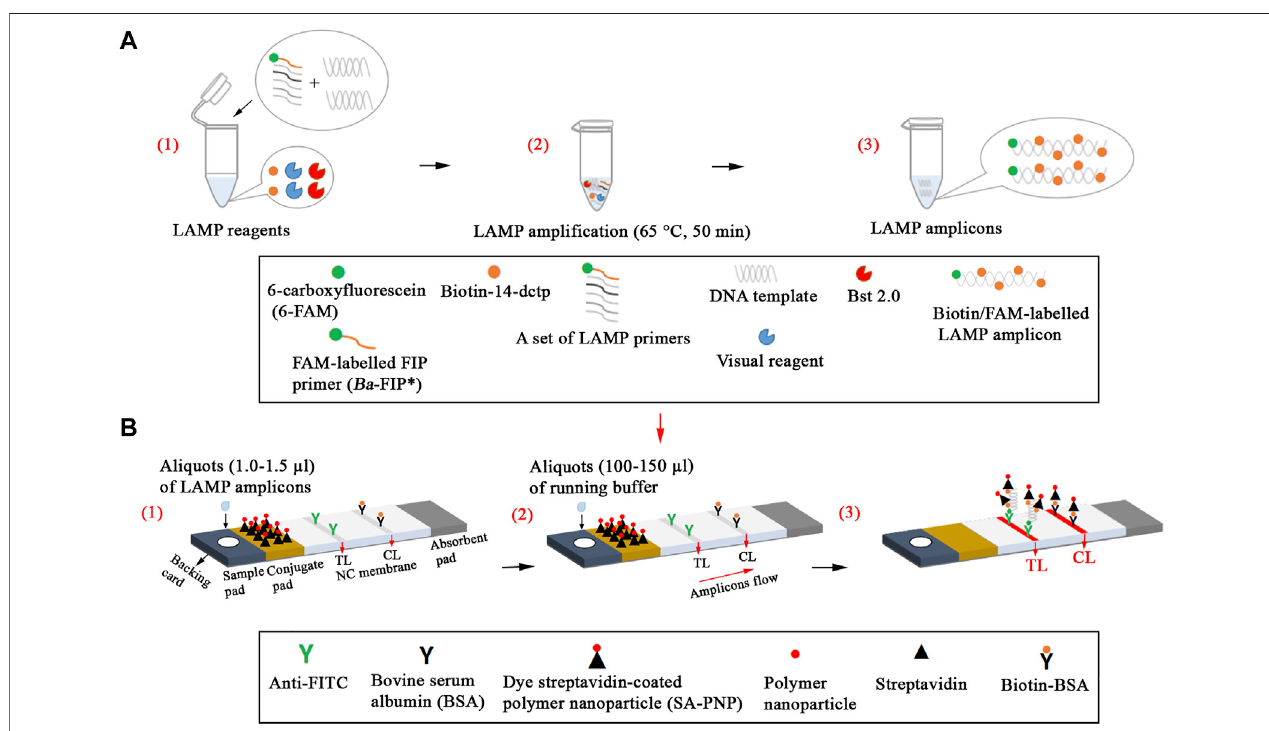
FIGURE 1 | Schematic description of the B. abortus -LAMP-LFIA assay. (A1) , Preparing the reaction mixtures. (A2) , B. abortus -LAMP ampli fi cation. (A3) , The detectable LAMP amplicons after ampli fi cation. B. abortus -LAMP amplicons were simultaneously labeled with FAM and biotin. (B1) , Aliquots (1.0 – 1.5 µl) of LAMP ampliconswasdepositedonthesamplepadofLFIA. (B2) ,Aliquots(100 – 150 µl)ofrunningbufferwerealsodepositedonthesamplepadofLFIA. (B3) ,Thebiotin/FAM- labeled ampli fi cation products were captured by the anti- fl uorescein body (anti-FITC) fi xed on the test line (TL) of the biosensor; the surplus SA-PNPs (dye streptavidin-coated polymer nanoparticle, crimson red) were captured by the biotin-BSA (biotinylated bovine serum albumin) fi xed on the control line (CL) of the biosensor, which demonstrated the working condition of the biosensor. 6-FAM, 6-carboxy fl uorescein; B. abortus , Brucella abortus ; LAMP, loop-mediated isothermal ampli fi cation; LFIA, lateral fl ow immunoassay